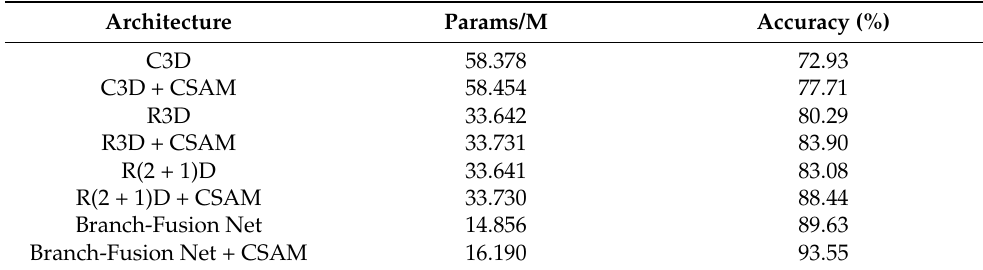
Table 8. Accuracy comparison on the Kinetics dataset.